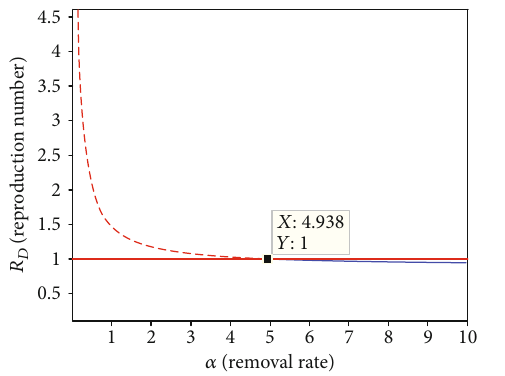
α . D as a function of